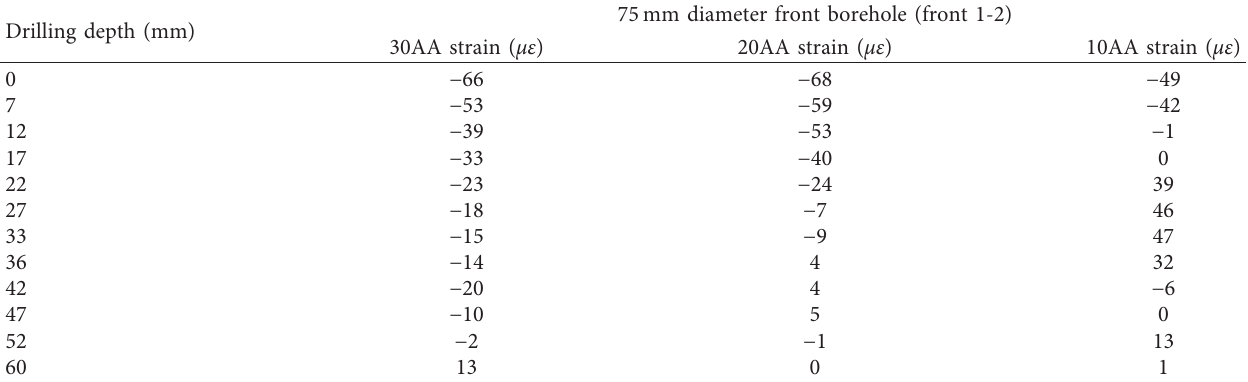
Table 3: Experimental measurements collected from the first beam.